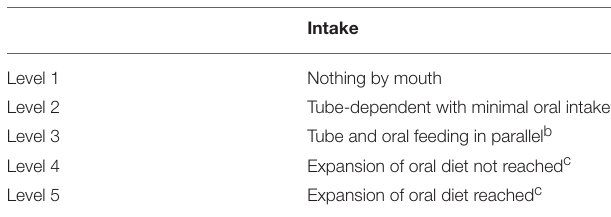
FIGURE 1 | Acquisition of data relevant to the FOIS for infants and the feeding status after 1 year FOIS, functional oral intake scale; VFSS, videofluoroscopic swallowing study; NOF, non-oral feeding; POF, partial oral feeding; FOF, full oral feeding. TABLE 6 | The functional oral intake scale for infants considering both attempts and amounts of oral intake at level